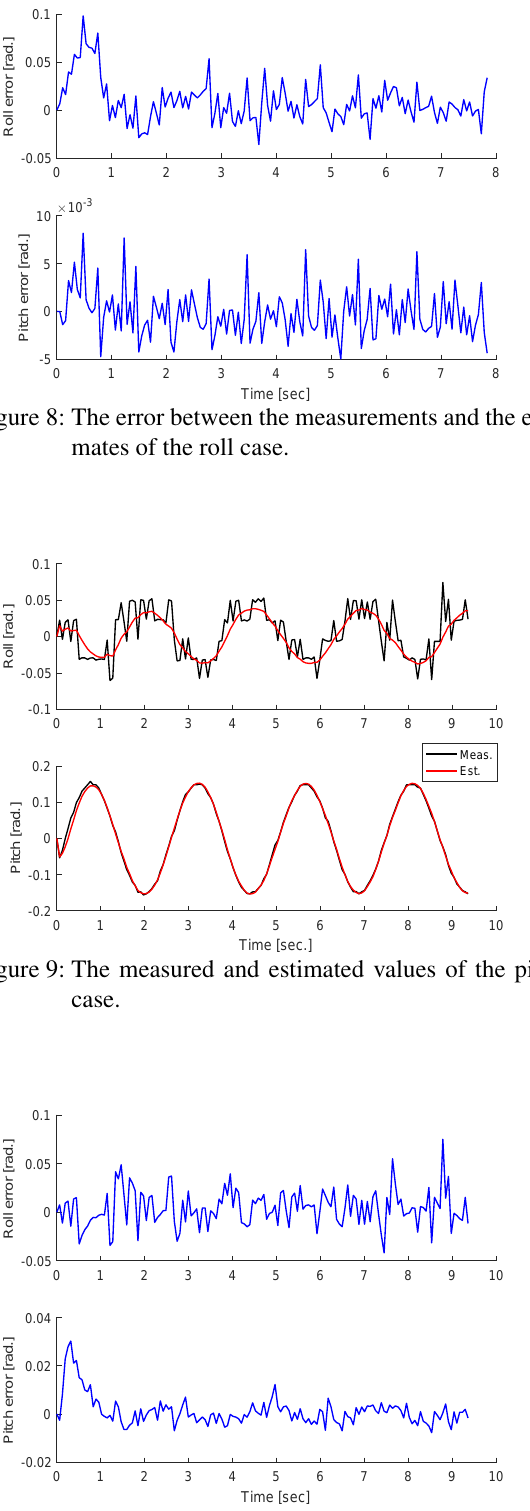
Figure 10: The error between the measurements and the es- timates of the pitch